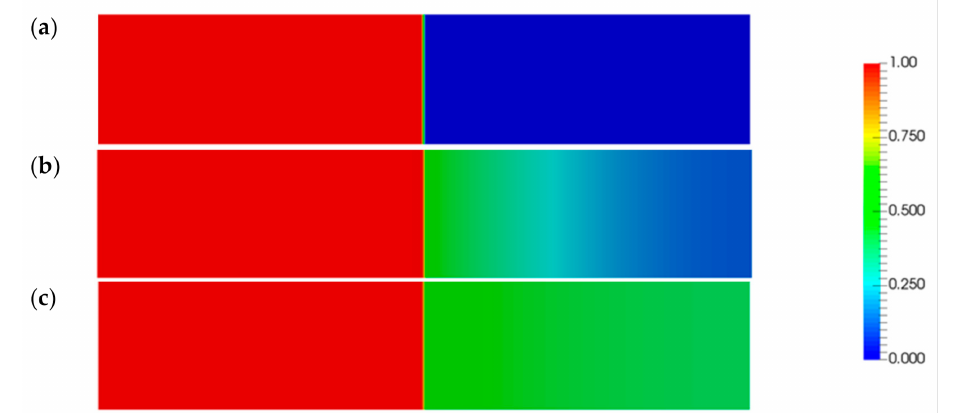
Figure 1. Solvent mole fraction distribution along the length of the capillary at different time steps; ( a ), ( b ), and ( c ) are initial, middle and final time steps, respectively. The red region is the vapor (solvent-rich) phase that is separated from the oleic phase by a sharp interface. Solvent mole fraction differs in the range of 1.0 (red) meaning pure solvent phase to 0.0 (blue) meaning no solvent present in the